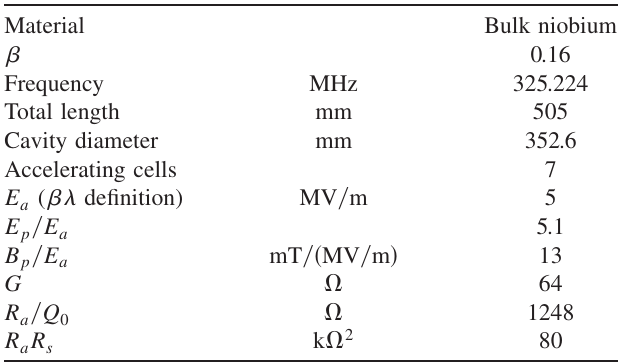
TABLE I. Main parameters of the 325 MHz CH cavity.